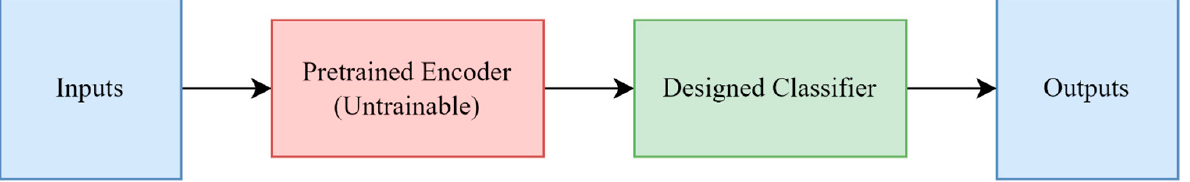
Figure 9. A simple presentation of the classifier included by the untrainable encoder, which is the only difference, compared to Figure 4.